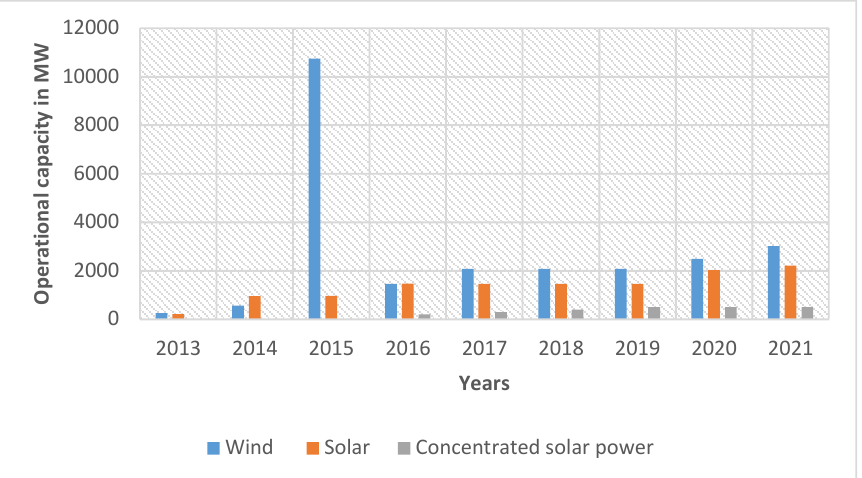
Figure 1. Operational capacity of solar, wind and concentrated solar power energy from 2013 to 2021. Adapted from [8].